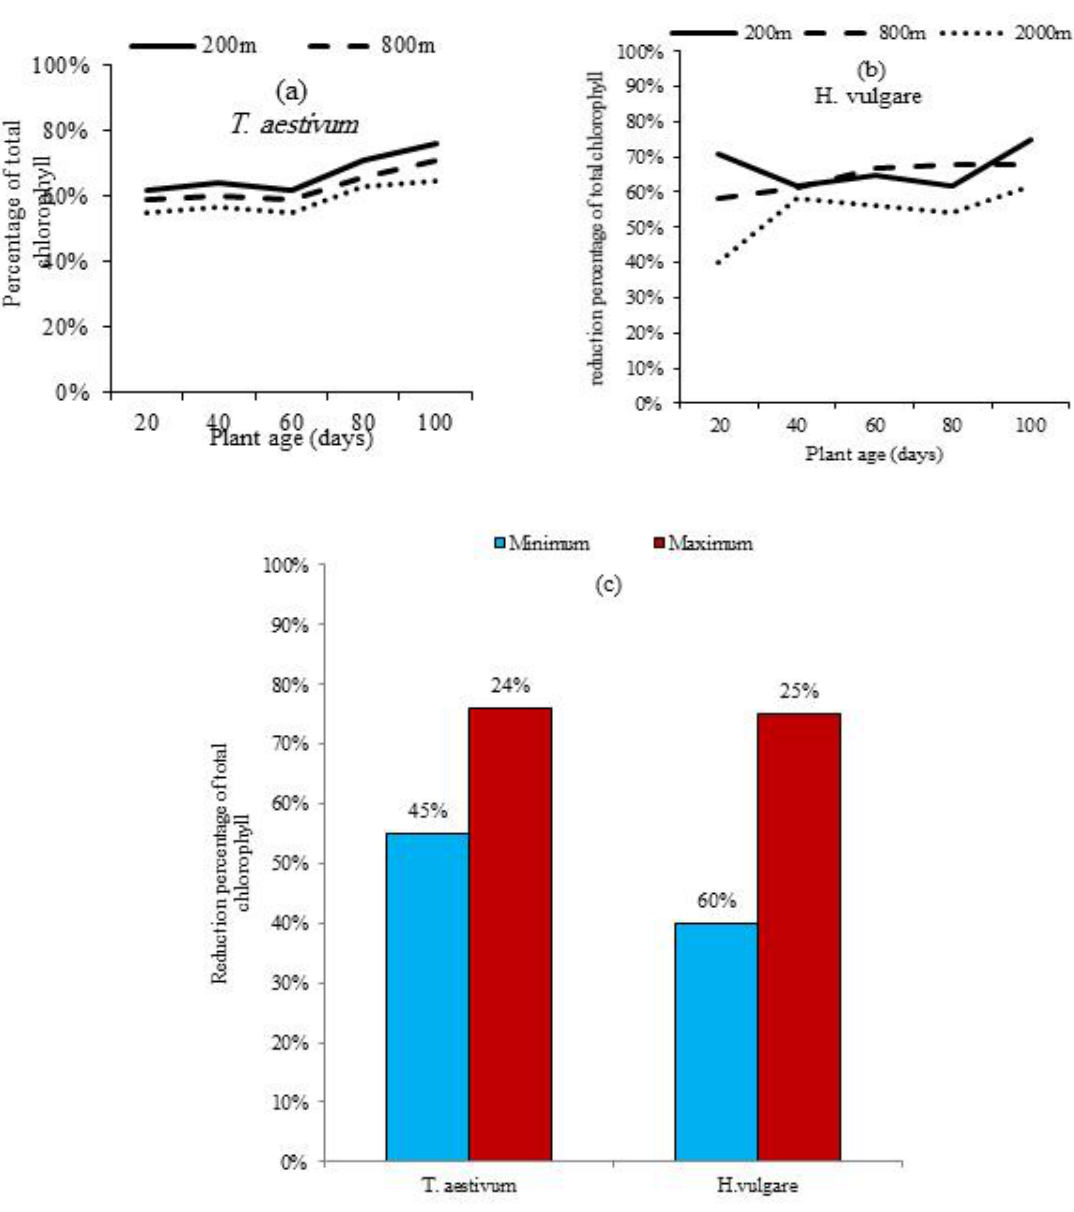
Fig. 4: Percentage of total chlorophyll of polluted samples than to control in T. aestivum (a) and H.vulgare (b). Comparing of minimum and maximum percentage of two plant species